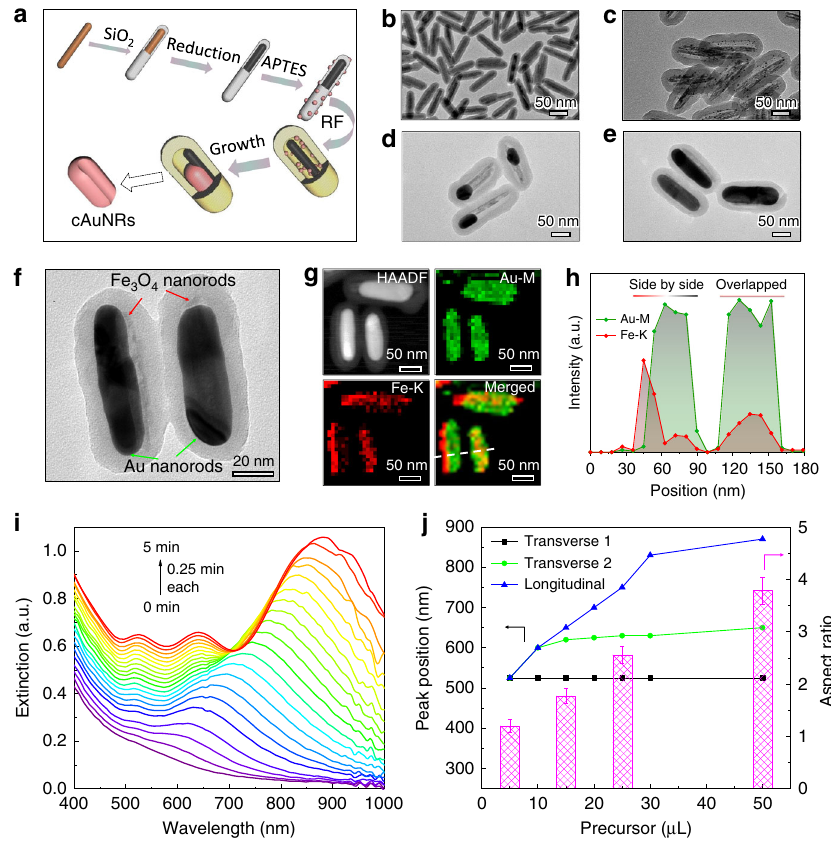
Fig. 1 Synthesis and characterization of magnetic-plasmonic hybrid nanostructures. a Scheme of the con fi ned growth towards magnetic-plasmonic hybrid nanorods. In the last step of the scheme, Fe 3 O 4 nanorod and RF shell are removed to clarify the concave structure of the Au nanorod. TEM images of nanorods after SiO 2 coating ( b ), RF coating ( c ), seeded growth with 15 µ L ( d ), 25 µ L ( e ) of the precursor. f TEM image showing hybrid nanorods with two typical con fi gurations (left: side by side; right: overlapped). g HAADF and EDS mapping images of the hybrid structures. h The cross-sectional line pro fi le of element distribution. i The real-time extinction spectra of cAuNRs with a time interval of 15 s. j Dependence of peak positions of surface plasmonic resonance and aspect ratios of cAuNRs on the volume of the precursor. The reaction kinetics is controlled by adding different amounts of precursors as indicated. Error bars represent the standard deviations from the measurement of ten hybrids nanorods in TEM